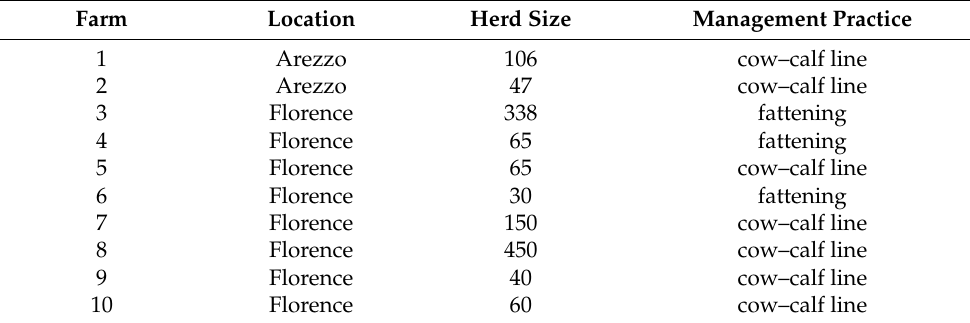
Table 1. Characteristics of the farms included in the study .